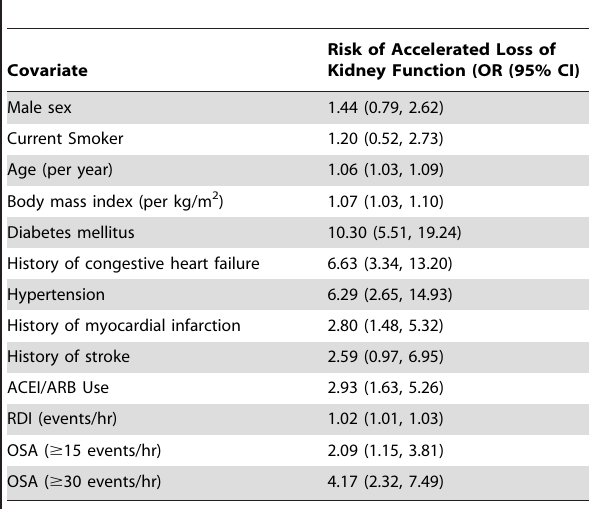
Table 2. Univariate analysis for risk of accelerated loss of kidney function.